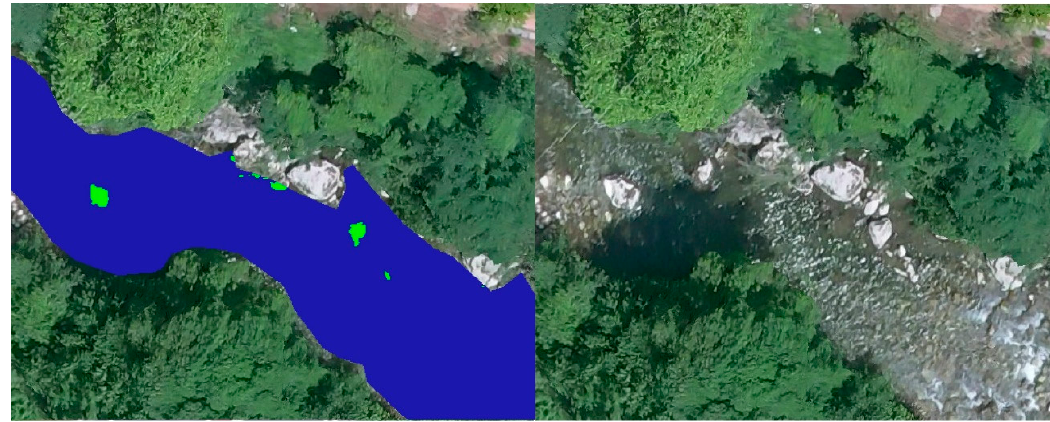
Figure 13. Error zones.